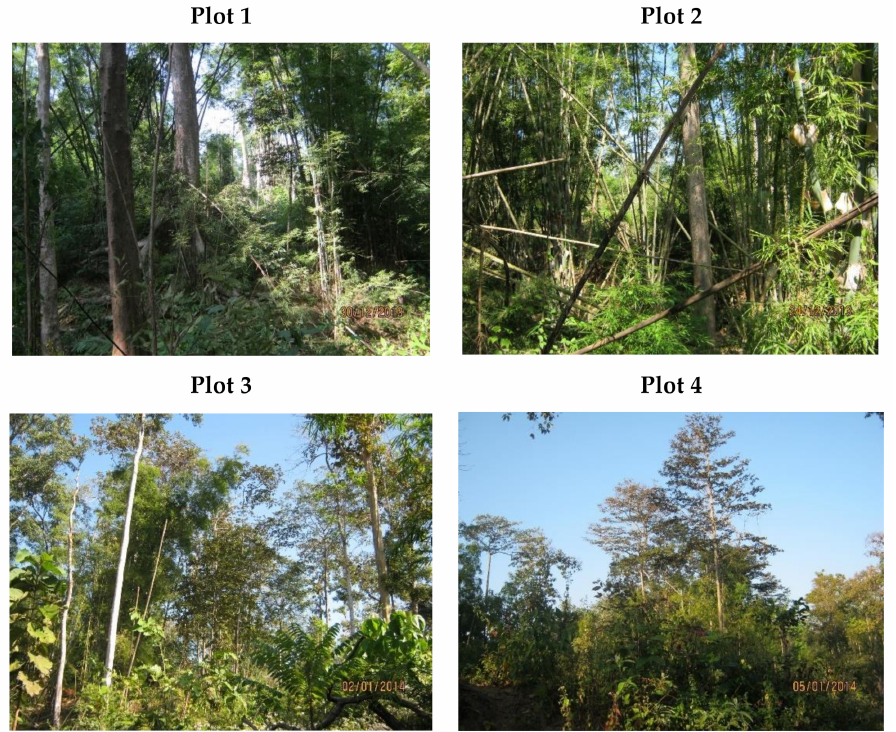
Figure 4. Photographs of the four plots in December 2013 and January 2014.